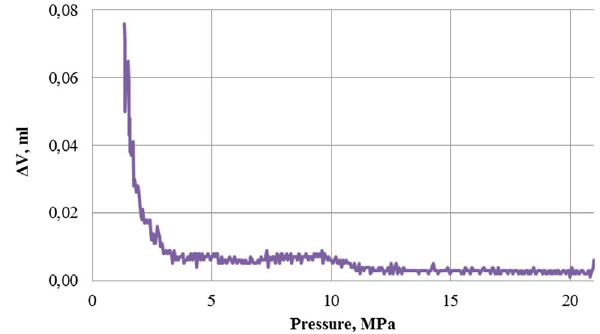
Fig. 10 Effect of pressure on volumetric gain (Δ V ) of the system at temperature of 52